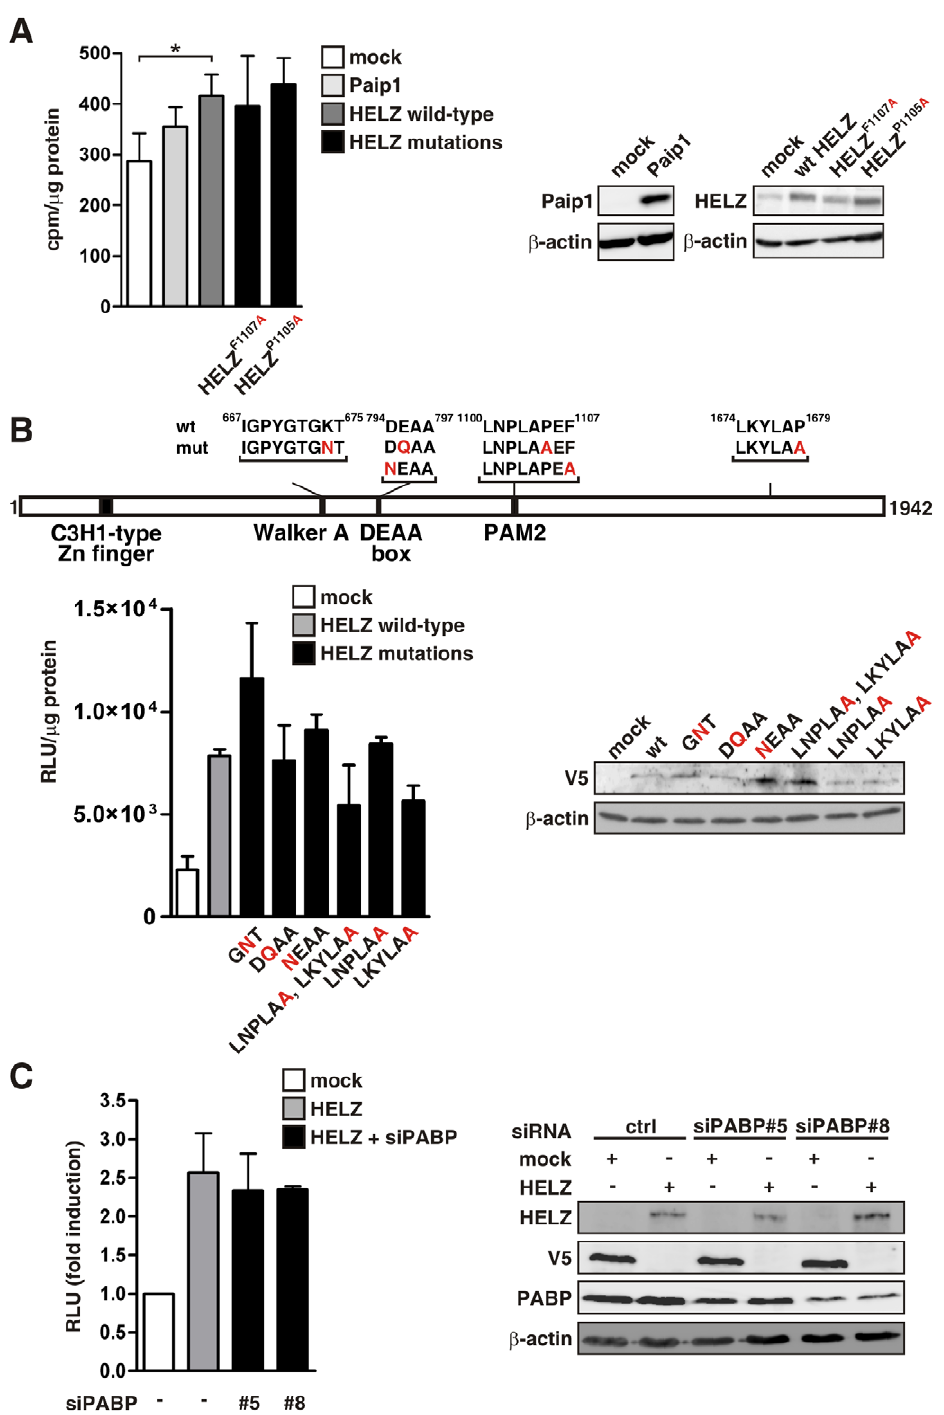
Figure 5. HELZ regulates global protein translation. ( A ) HeLa cells were transfected with 3 m g of the indicated constructs and 48 hours later pulse-labeled with [ 35 S]-methionine for 1 hour. Incorporated radioactivity was measured by scintillation counting following TCA precipitation and results were normalized to total protein levels (left panel). Protein overexpression was controlled by immunoblotting (right panel). ( B ) Schematic depiction of the different HELZ mutations (upper panel). HeLa cells were co-transfected with the indicated HELZ constructs together with pRL-SV40 and cultivated for 48 hours before luciferase activities were determined and normalized to total protein concentrations (lower left panel). Expression of V5-tagged constructs was controlled by immunoblotting (lower right panel). ( C ) HeLa cells were transfected with mock control, HELZ or HELZ in combination with PABP siRNA oligonucleotides and analyzed as described under ( B ). Expression of the transfected vectors and PABP knock-down efficiencies were controlled by immunoblotting (right panel). Results are presented as mean values 6 standard error of the mean of n=3 independent experiments.